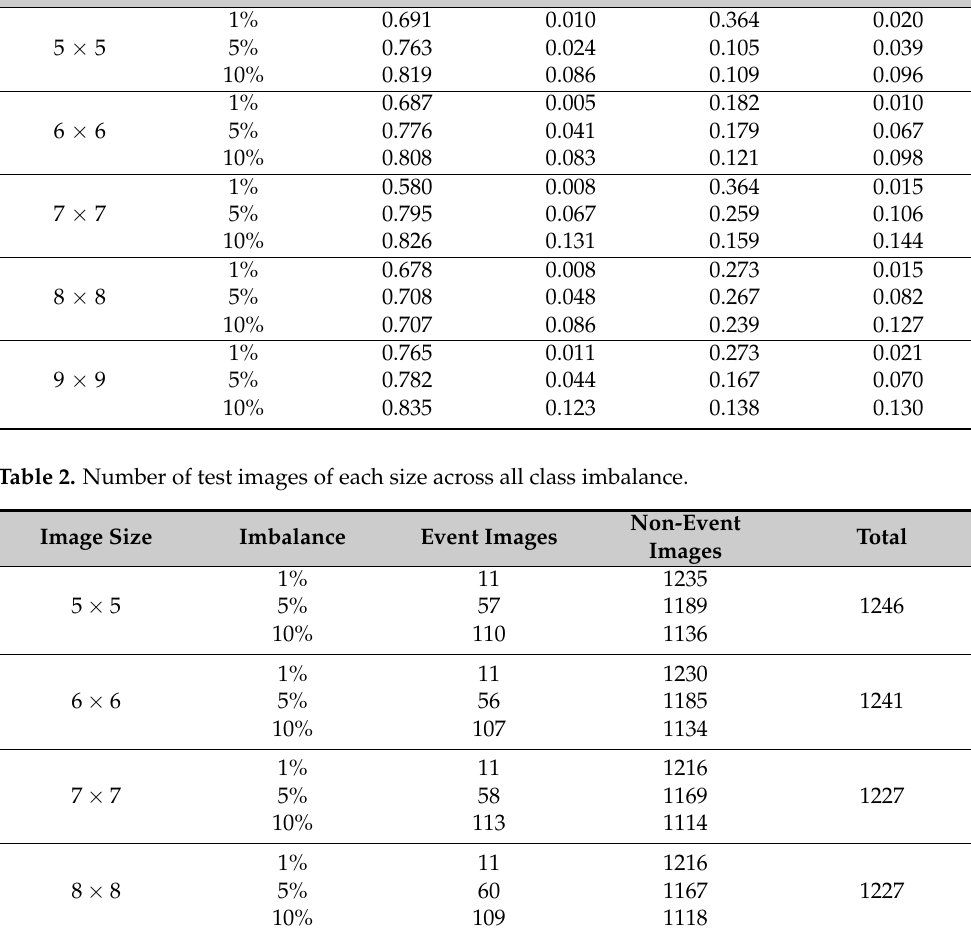
Table 1. Comparing performance metrics in the test data set across all image sizes and class imbal- ance ratios. Image Size